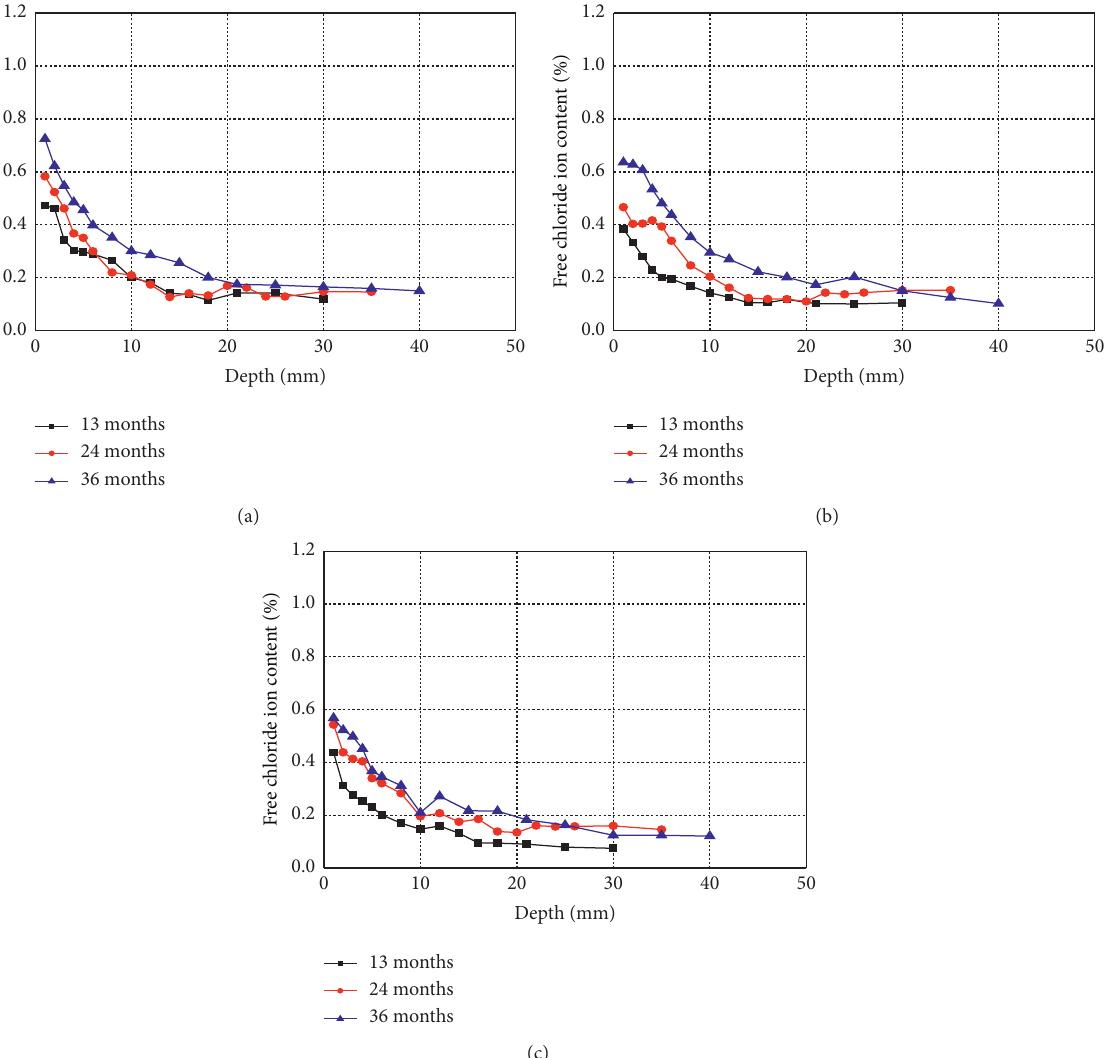
Figure 7: Chloride ion profile of concrete mixed with fly ash. (a) Fly ash � 15%. (b) Fly ash � 30%. (c) Fly ash �